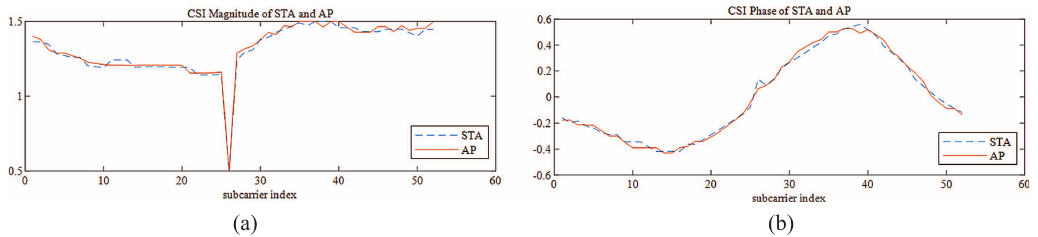
Figure 8. CSI magnitude and phase maps after preprocessing: (a) CSI magnitude map after preprocessing; (b) CSI phase map after preprocessing